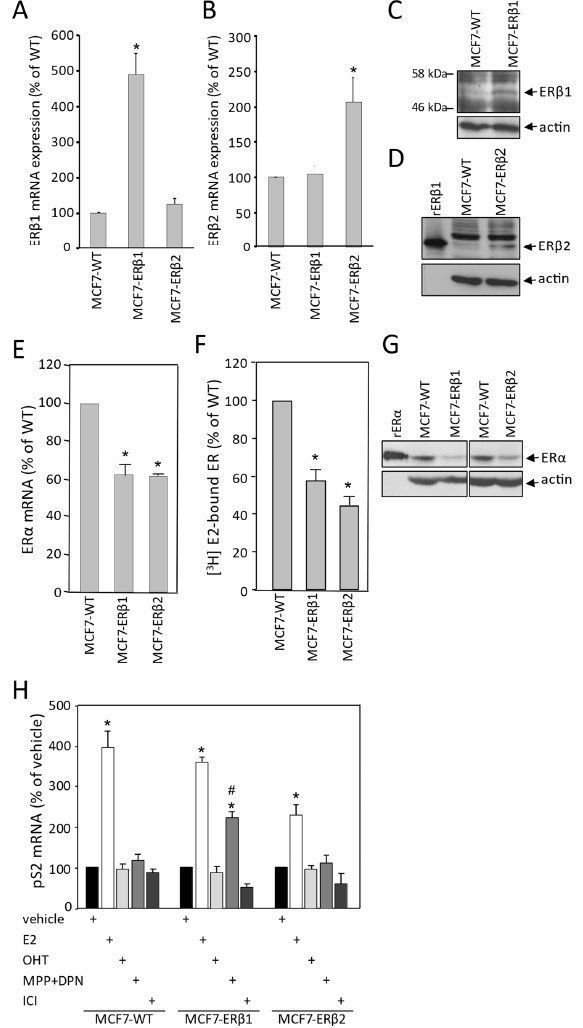
Figure 1. Establishment of clones of MCF7 cells stably expressing human ER β 1 or ER β 2. ( A , B ) mRNA levels of ER β 1 ( A ) and ER β 2 ( B ) in MCF7-ER β 1 and MCF7-ER β 2 cells were assessed by RT-qPCR and expressed relative to the levels in MCF7-WT cells. Values are mean ± SEM of at least three independent experiments carried out in triplicate. * p < 0.05 vs. WT cells ( t -test). ( C , D ) Protein levels of ER β 1 in whole cell extracts from MCF7-WT and MCF7-ER β 1 ( C ) and ER β 2 in whole cell extracts from MCF7-WT and MCF7-ER β 2 cells ( D ) as assessed by Western blot analysis using antibodies against ER β 1, ER β 2 and actin (loading control). ( E – G ) ER β 1 or ER β 2 expression reduced ER α expression levels in MCF7 cells. ( E ) mRNA levels of ER α in MCF7-WT, MCF7-ER β 1 and MCF7-ER β 2 cells were assessed by RT-qPCR and expressed relative to the levels in MCF7-WT cells. ( F ) Levels of ER competent in high-affinity [3H]E2 binding were assessed in MCF7-WT, MCF7- ER β 1 and MCF7-ER β 2 cells by whole cell binding assays. Values are mean ± SEM of at least three independent experiments carried out in triplicate. * p < 0.05 vs. WT cells ( t -test). ( G ) Protein levels of ER α in whole cell extracts from MCF7-WT, MCF7-ER β 1 and MCF7-ER β 2 cells as assessed with Western blot analysis using antibodies against ER α and actin (loading control). ( H ) ER β 1 is transcriptionally active in MCF7 cells: mRNA levels of pS2 gene in MCF7-WT, MCF7-ER β 1 and MCF7-ER β 2 cells, cultured in steroid-free medium and treated for 24 h with vehicle (0.1% DMSO), E2 (10 nM) or 100 nM of OHT, MPP+DPN or ICI were assessed by RT-qPCR and expressed relative to the respective levels upon treatment with vehicle alone. Values are mean ± SEM of at least three independent experiments carried out in triplicate. * p < 0.05 vs. vehicle of the respective cell line, # p < 0.05 vs. similarly treated MCF7-WT cells ( t -test). OHT, 4-hydroxytamoxifen; MPP, methyl-piperidino-pyrazole; DPN, diarylpropionitrile; ICI,